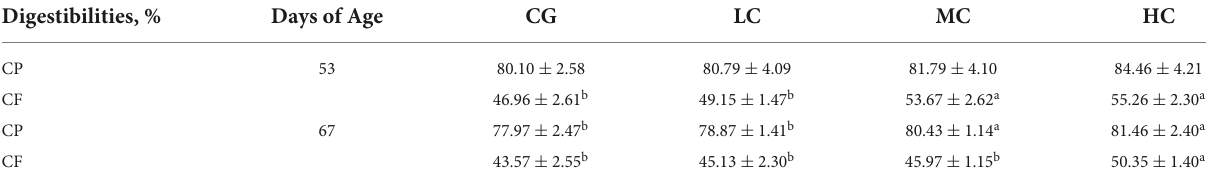
TABLE 2 The effects of C. butyricum on nutrients digestibilities in Ira rabbit cecum. Digestibilities, %